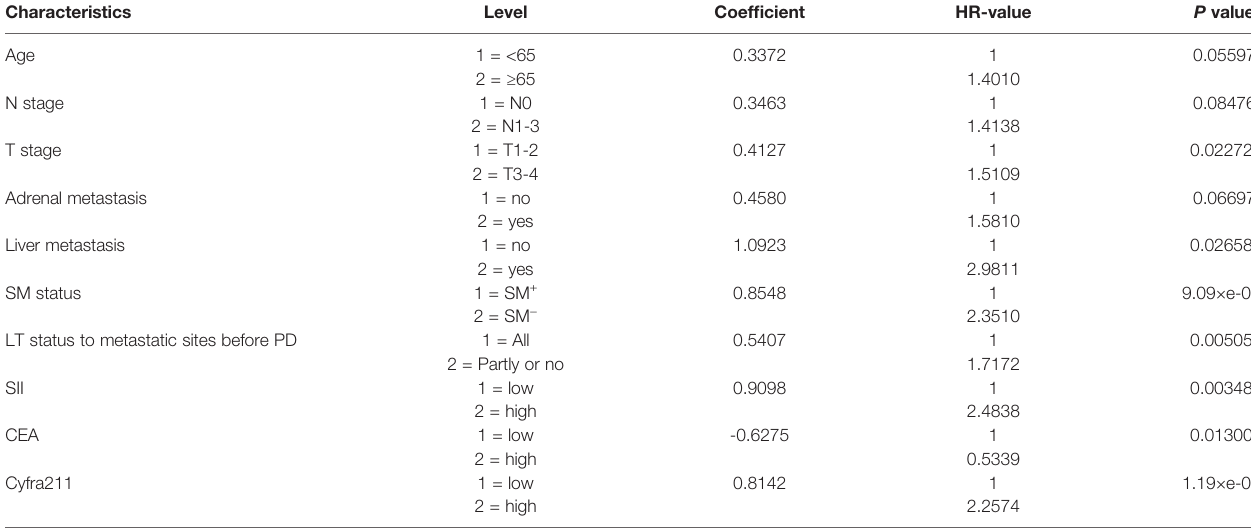
TABLE 3 | Factors included in the Risk-Total formula. Characteristics